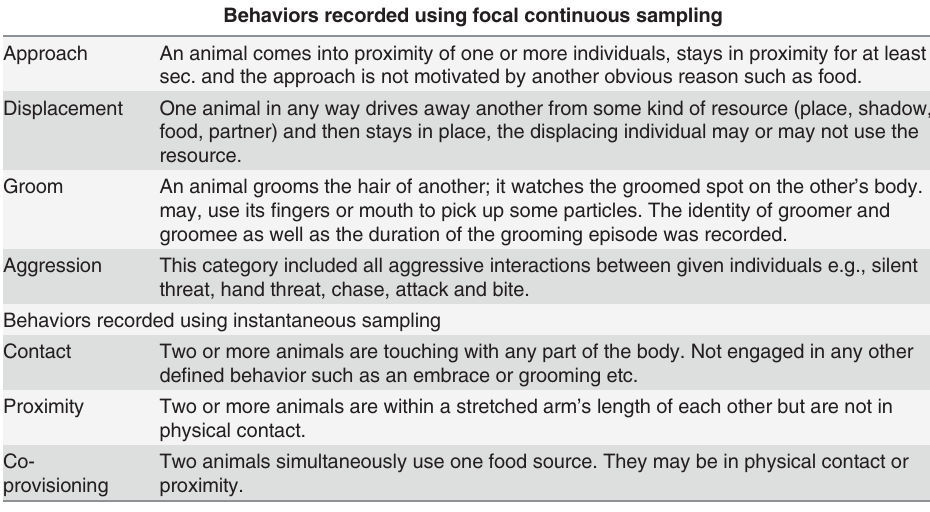
Table 1. List of behaviors and their de fi nitions used for analyses. Behaviors recorded using focal continuous